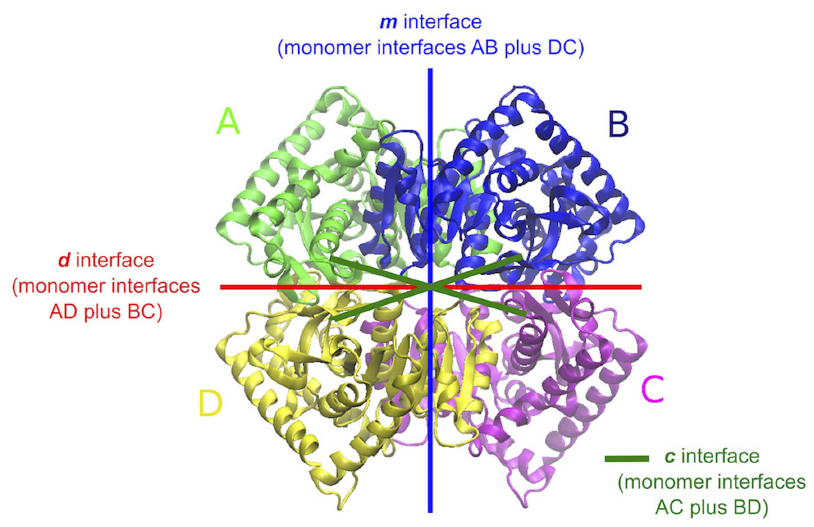
Figure 1. Structure of the MalDH tetramer. The above structure belongs to the thermophilic ( T ) homologue but the chain and interface nomenclatures in the figure apply also for the mesophilic one ( M ). The tetramer is best described as a dimer of dimers. In the figure, the subunits A + B and C + D constitute each of the two dimers, which in turn interact with each other to form the tetramer. In order to study the interfacial interactions in a rather efficient way we have decomposed them into three different kinds comprising interfaces m , d and c the definition of which can be seen